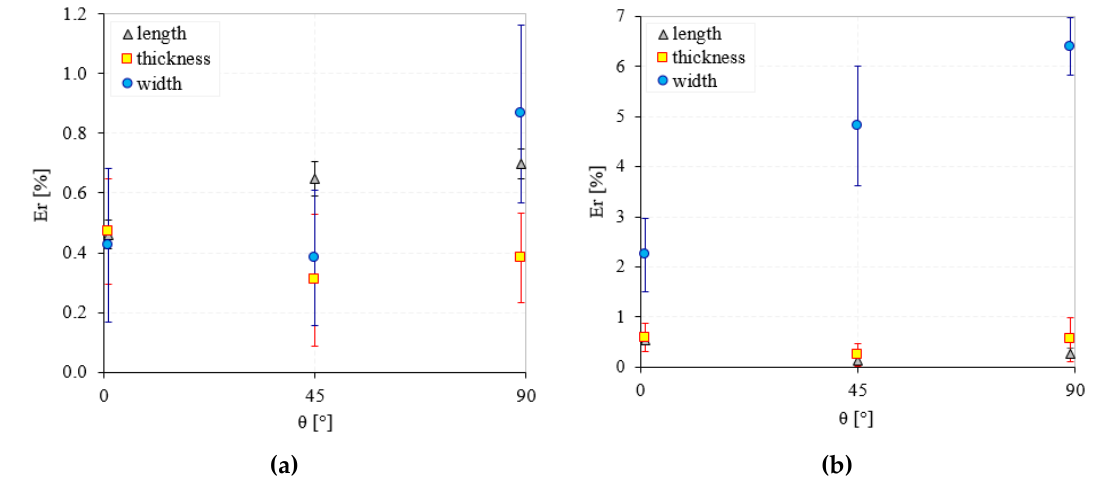
Figure 4. Relative dimensional errors of polyamide ( a ) and Alumide ( b ) samples.